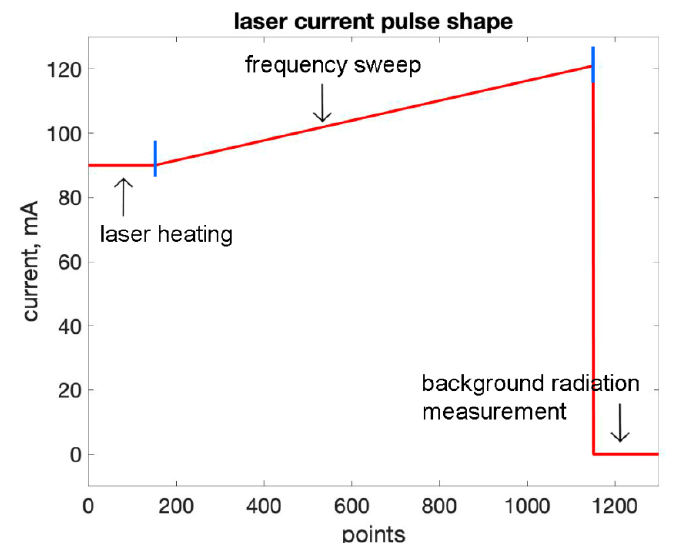
Figure 5. The schematic structure of the pumping current pulse, which consists of three stages: laser heating, frequency sweep, and background radiation measurement.